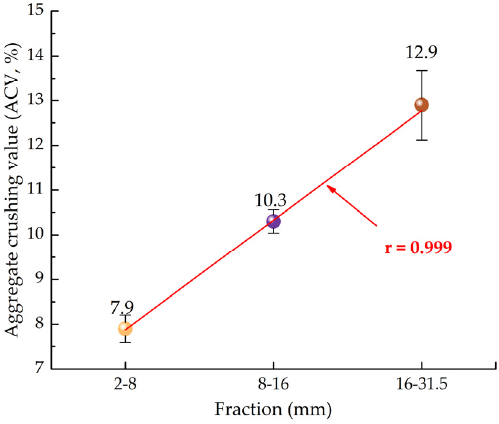
Figure 2. Correlation between aggregate crushing value and aggregate fraction.